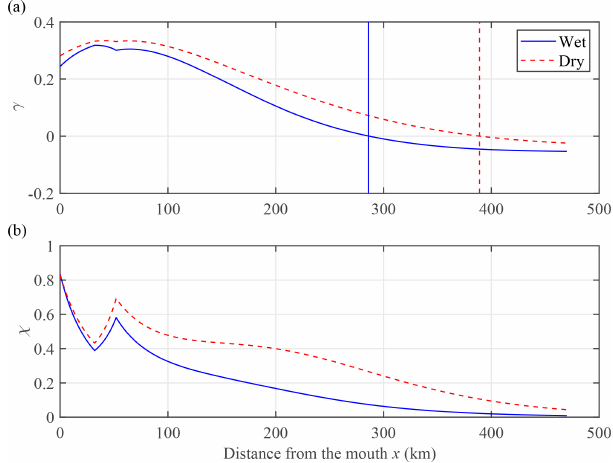
Figure 9. Longitudinal variation of the estuary shape number γ (a) and the friction number χ (b) for the wet and dry seasons in the Yangtze River estuary. Panel (a) also indicates the position of the critical value of channel convergence (i.e. γ = 0) using the cor- responding lines for the wet and dry